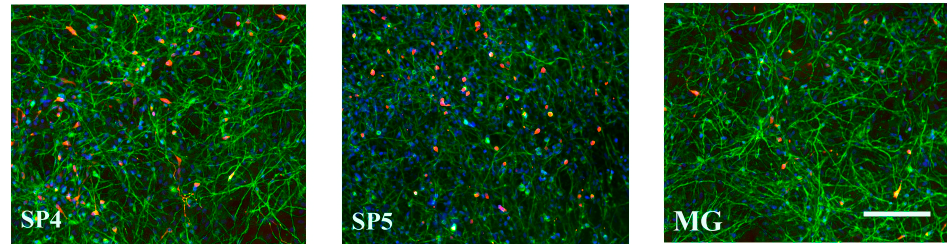
Figure 8. Immunocytochemical staining of DNs obtained by the cultivation of NPC on the CCs and MG using antibodies against TUBB (green), TH (red), and DAPI (blue). Representative photographs. Scale line is 100 μ m.